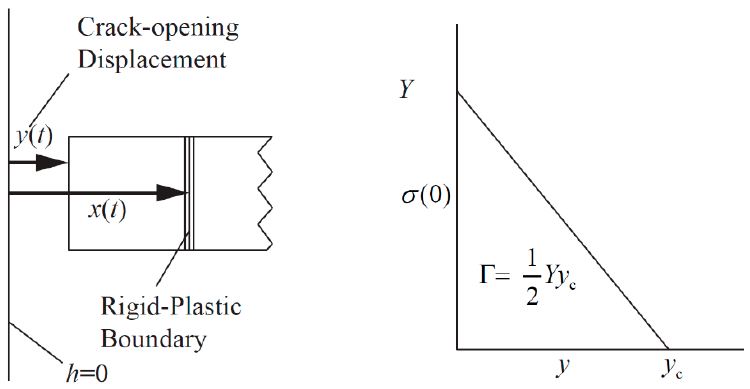
Figure 5. Schematic diagram of Grady one-dimensional fracture model.